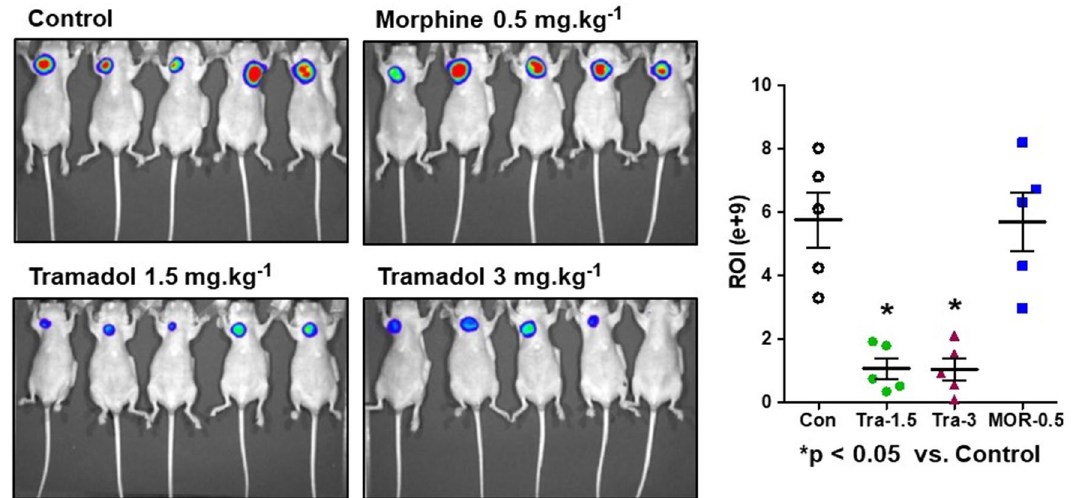
Figure 1. Comparison of tumor growth using the Spectrum in vivo imaging system. Xenografted mice were randomly divided into four different groups with 5 mice per group: control group (Con, saline only), tramadol group 1 (Tra-1.5, 1.5 mg kg −1 day −1 ), tramadol group 2 (Tra-3, 3 mg kg −1 day −1 ), and morphine group (MOR-0.5, 0.5 mg kg −1 day −1 ). Mice bearing MCF7-Luc tumor were intraperitoneally injected with D-luciferin (150 mg